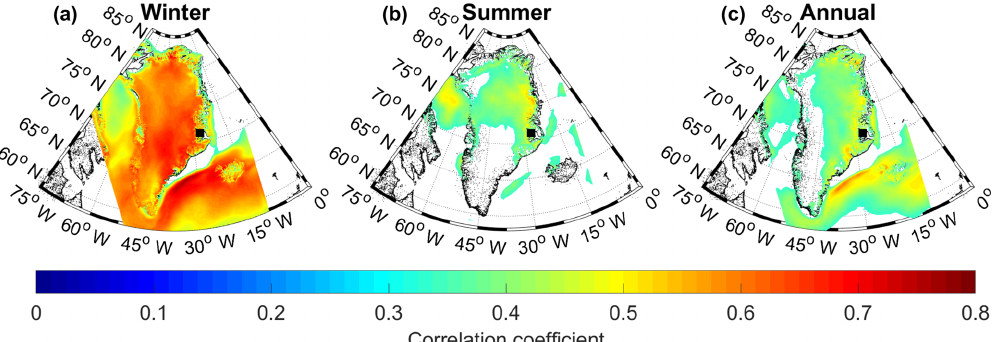
Figure 6. Figures showing the correlation between winter (a) , summer (b) and annually (c) averaged RECAP δ 18 O and HIRHAM5 temper- atures. Only correlations with p < 0 . 05 are shown.